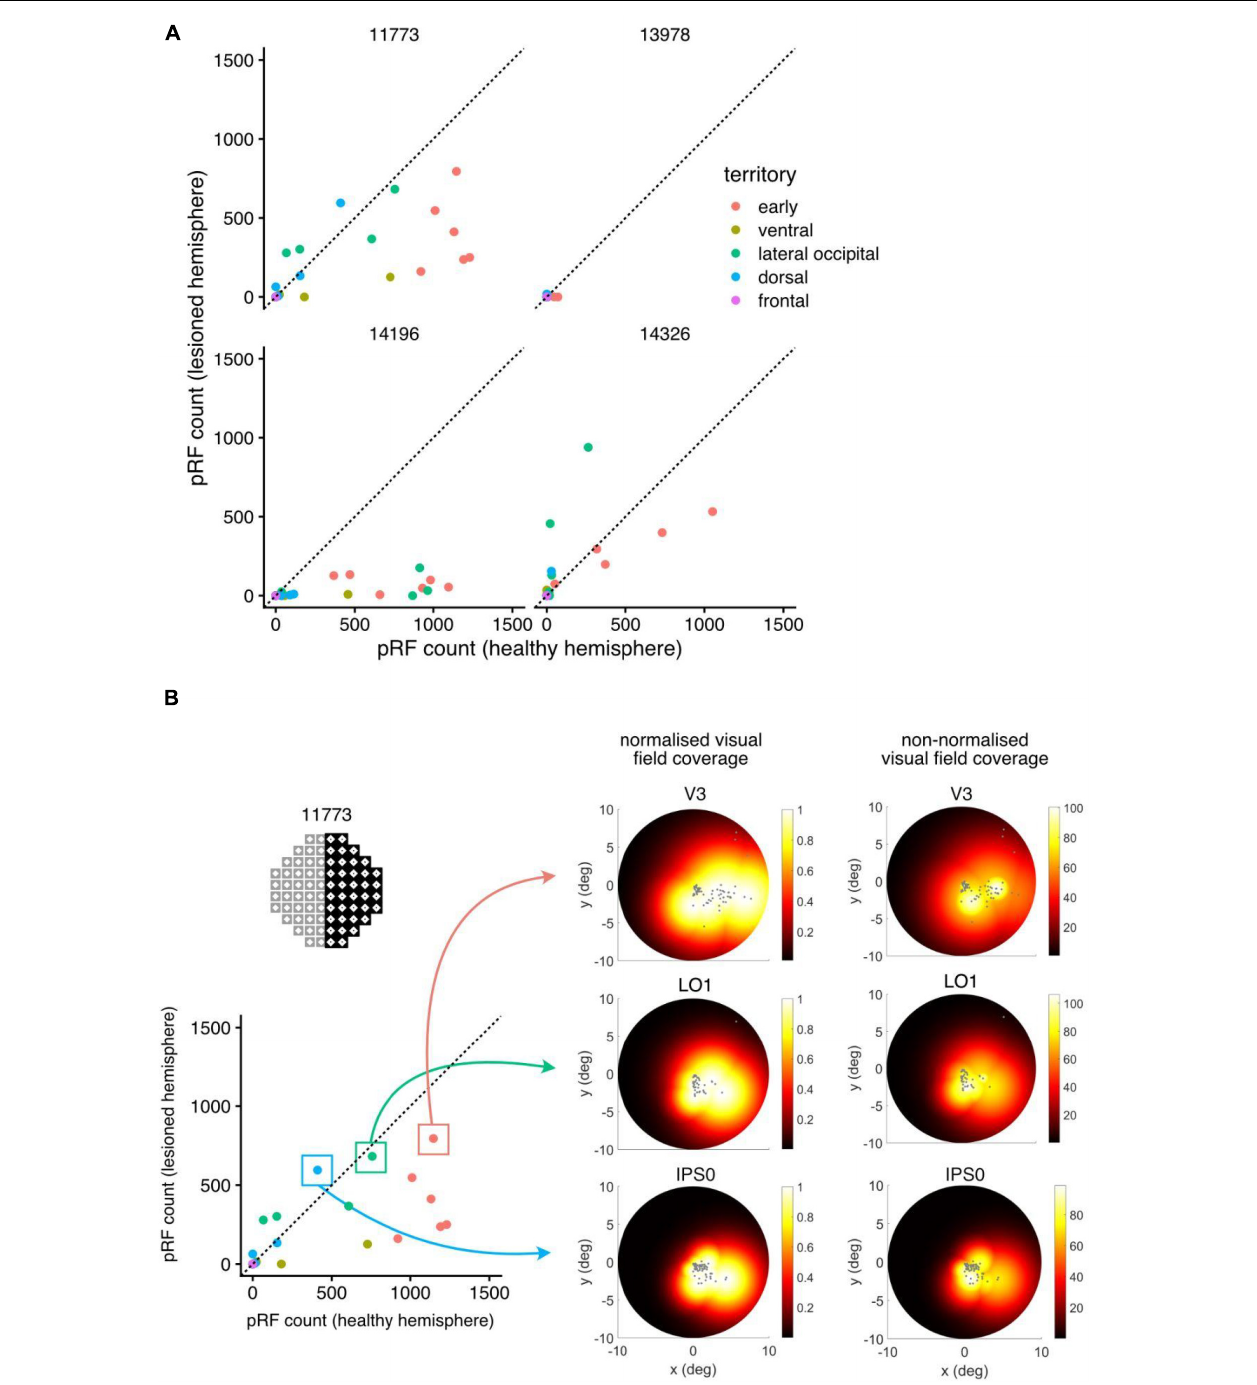
FIGURE 6 | Quantifying and visualizing residual function from population receptive fields (pRF). (A) Comparing population receptive field (pRF) results between the lesioned and healthy hemisphere (participant 11773). For each ROI, the number of pRFs (approximated as circles with radius σ ) that intersect with the convex hull of the scotoma was calculated. As a control, pRFs intersecting with the scotoma flipped into the non-affected field were counted—this corrects for changes in size of ROIs as well as the ability of the pRF model to fit responses in higher visual areas. Counts related to voxels in 1 mm standard space, so equivalent units are mm 3 . (B) Three ROIs with high pRF counts in the stroke hemisphere; the pRFs corresponding to voxels in this regions were used to construct normalized and non-normalized visual field coverage maps (cf Papanikolaou et al., 2014). The domain of the color map used for the non-normalized versions here spanned zero to the maximum pRF amplitude over all voxels. The visual field coverage maps across all three identified subregions show consistent coverage across the lower quadrant.